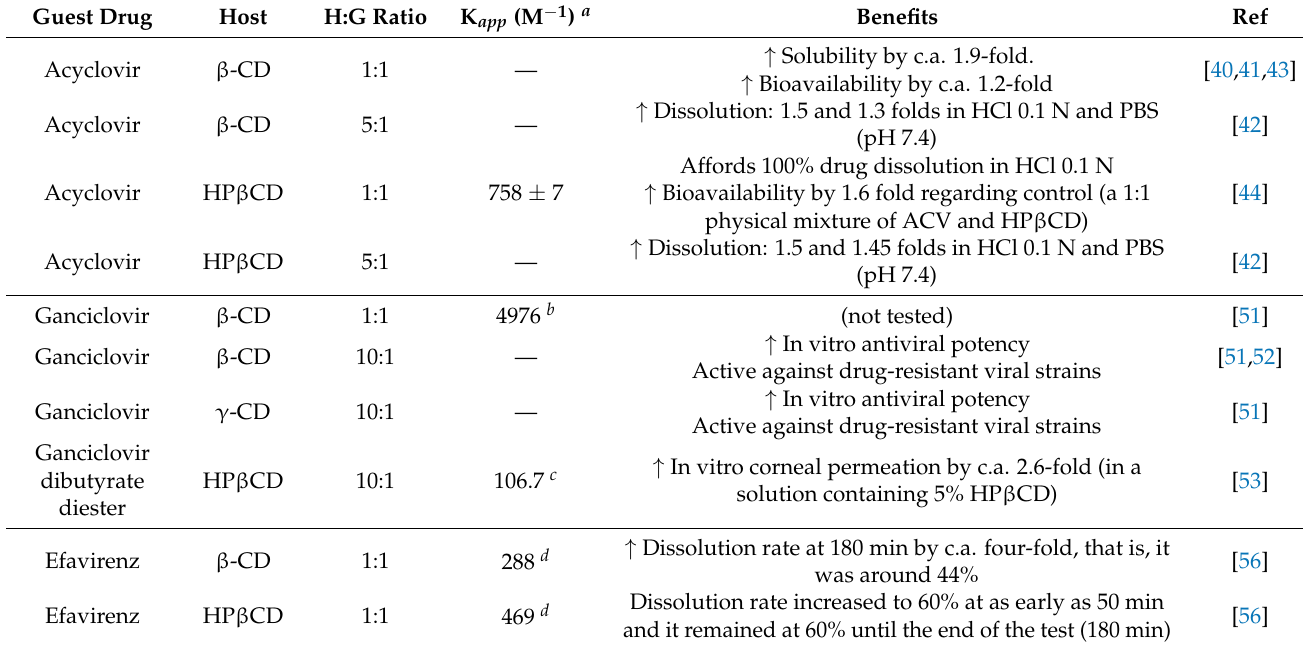
Figure 5. Structural representation of the interaction between remdesivir (molecules highlighted in green) and SBE β CD, as evaluated by molecular dynamics. Reproduced with permission from [86]. An overview of the herein described host-guest systems is presented in Table 3. Table 3. Summary of CD adducts/inclusion complexes with antiviral drugs, showing the tested stoichiometries of inclusion, the apparent affinity constant (K app ), and the advantages in their